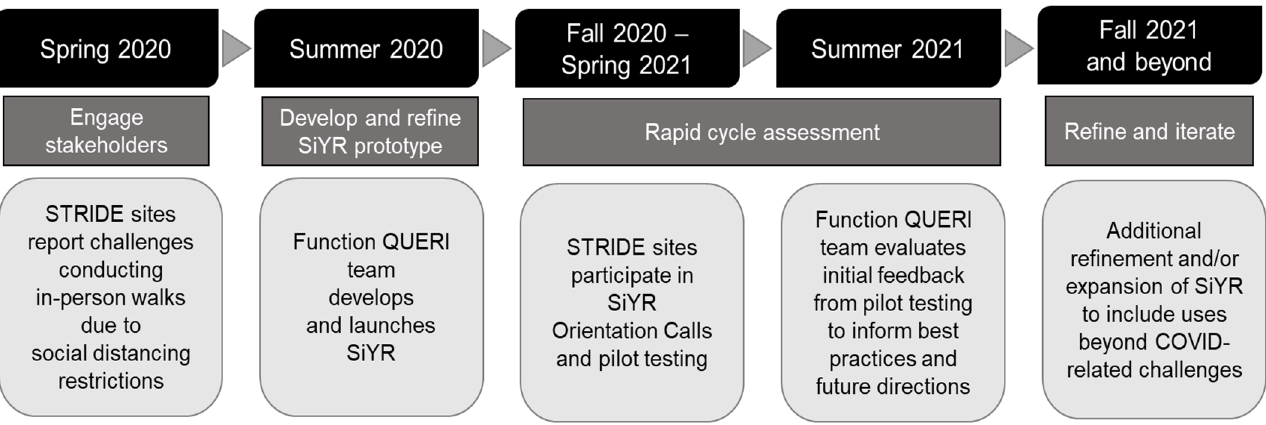
Figure 1. Evolution of STRIDE in Your Room (SiYR) program.